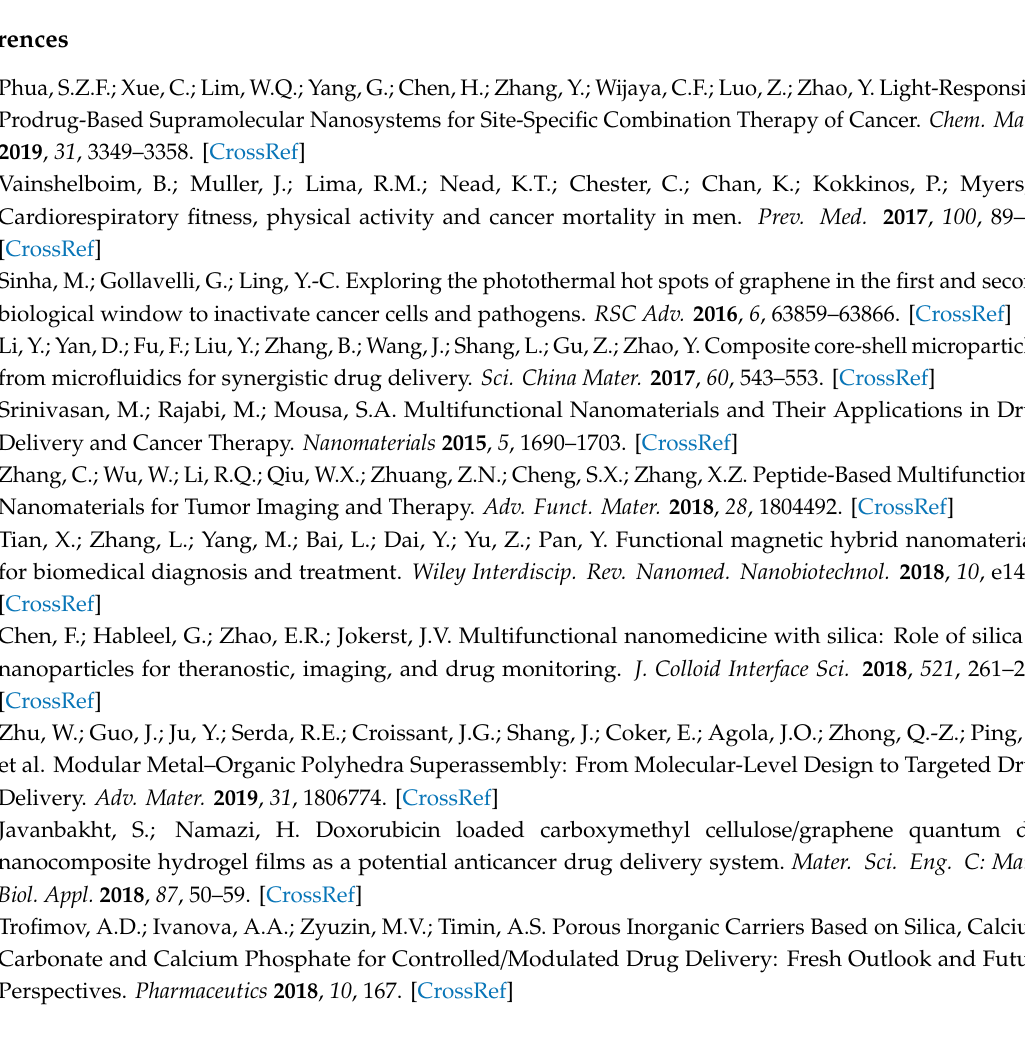
Figure S1: (a) stokes emission spectra of NYFT@MOFY-1 excited at di ff erent wavelengths, (b) stokes excitation spectra of NYFT@MOFY-1 by monitoring emission at di ff erent wavelengths, Figure S2: In vitro cell viability was measured by MTT assay after incubation of Hela cancer cells at di ff erent concentrations with pure NYFT@MOFY-1 nanocomposites for 4